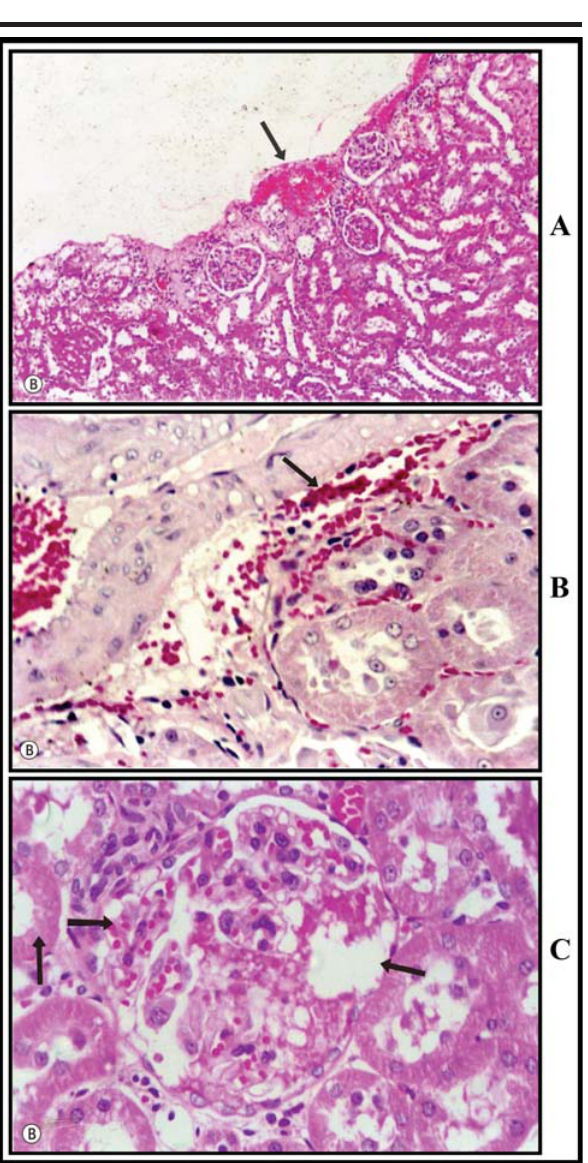
FIGURE 1 - Photomicrography of hemorrhagic focus (HF). A-subcapsular area and mild hemorrhage (arrow) (H&E-200X). B- interstitial area and mild hemorrhage (arrow) (H&E –400X). C- glomerular area and mild hemorrhage (arrows) on renal cortex. (H&E –400X)